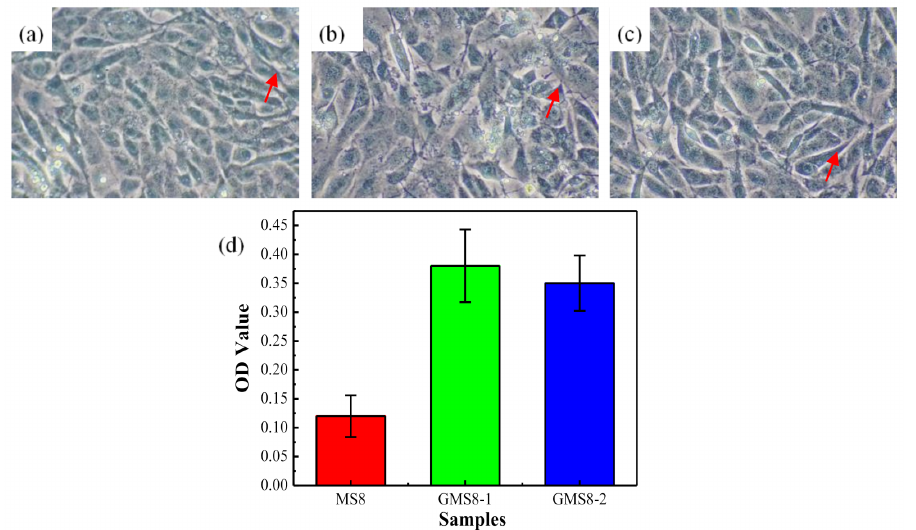
Figure 7. Alkaline phosphate activity of ME3T3-E1 cells with specimens extracts of MS8 ( a ), GMS8-1 ( b ), GMS8-2 ( c ); the corresponding OD values ( d